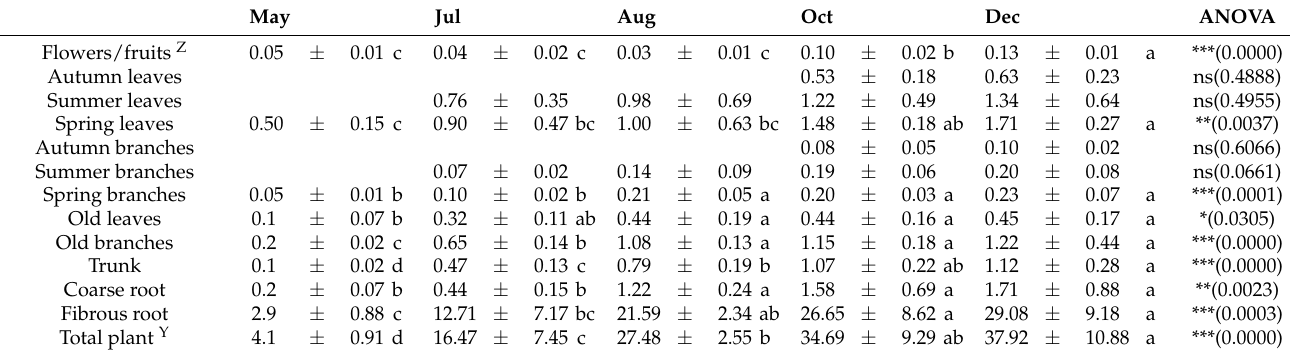
Table 5. 57 Fe uptake (mg 57 Fe) in the main organs of Nules clementine trees uprooted in May (flowering), July (fruit set and the end of fruit drop), August (fruit growth), October (fruit growth), and December (fruit maturity). Values are means ± SD (n = 4). Different lowercase letters indicate significant differences based on one-way analysis of variance. Significant effects of the Fe dose applied are given at p ≤ 0.05 (*), p ≤ 0.01 (**), p ≤ 0.001 (***), and ns (not significance) at each plant component. p -value between brackets (LSD